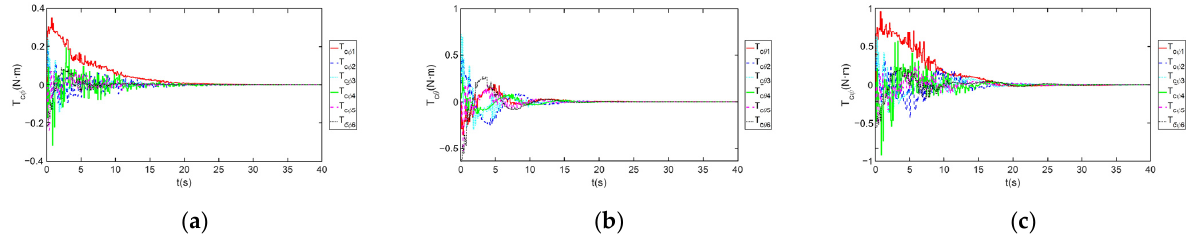
Figure 6. The control torque for the swarm utilizing LP systems: ( a ) Roll torque; ( b ) Pitch torque; ( c ) Yaw